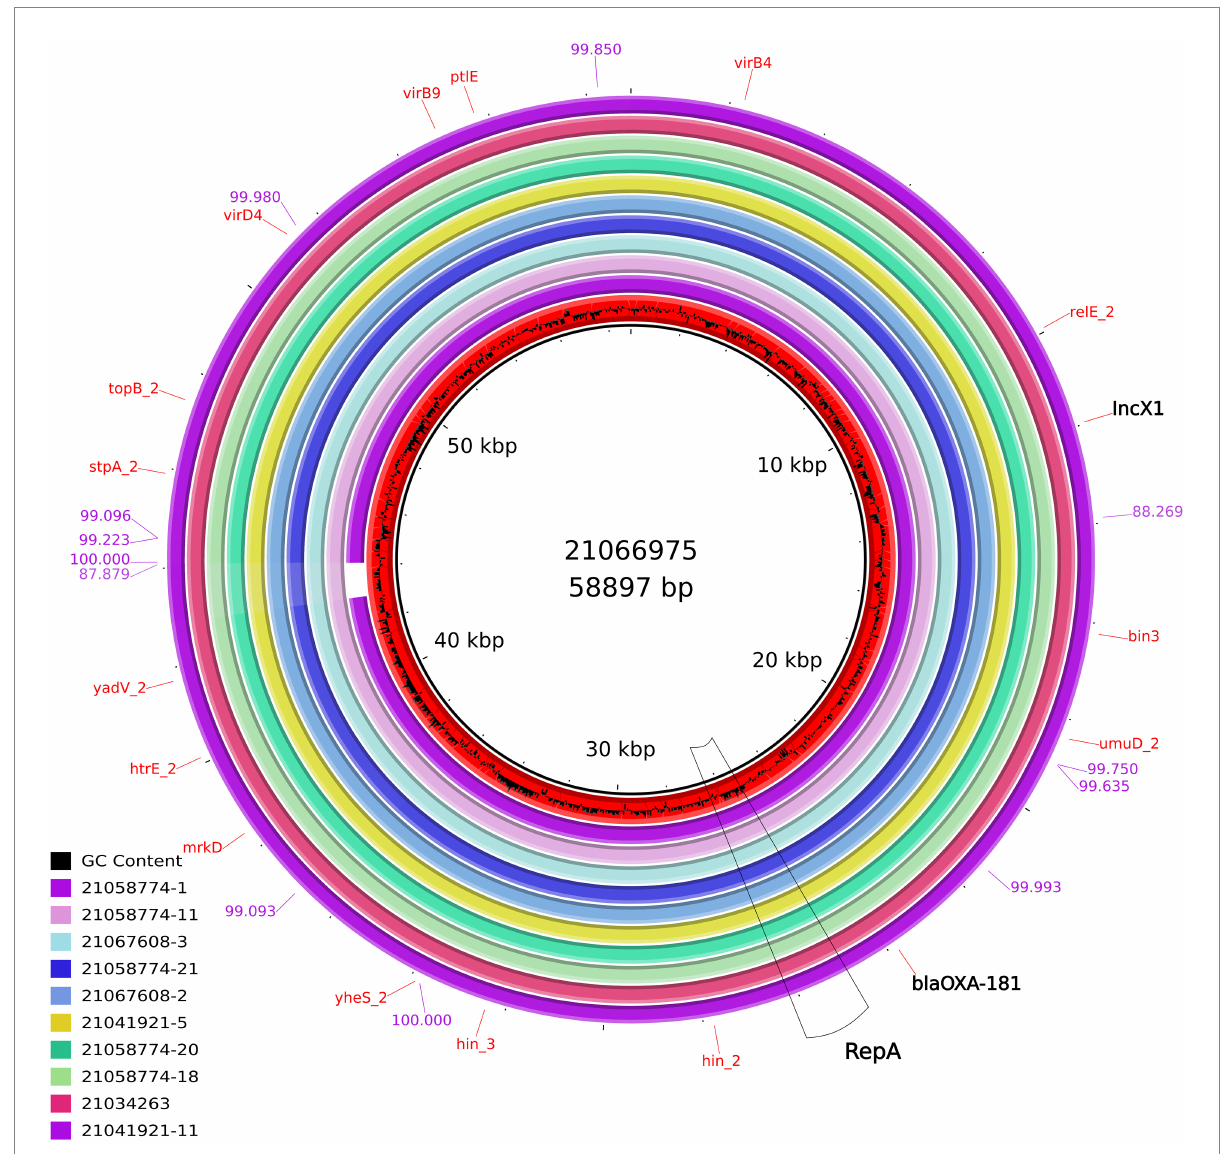
FIGURE 4 Comparison of the IncX1 plasmids from E.coli obtained in this study containing bla OXA-181 . From the inner circle, the plasmids represented were: ID21066975 used as reference (accession number ERS12413440, Escherichia coli, pig, caecal content at slaughterhouse) ID21058774-1 (Breeding pig), ID21058774-11 (Breeding pig), ID21067608-3 (Human), ID21058774-21 (Breeding pig), ID21067608-2 (Human), ID21041921-5 (Fattening pig), ID21058774-20 (Breeding pig), ID21058774-18 (Breeding pig), ID21034263-1 (pig, caecal content at slaughterhouse), and